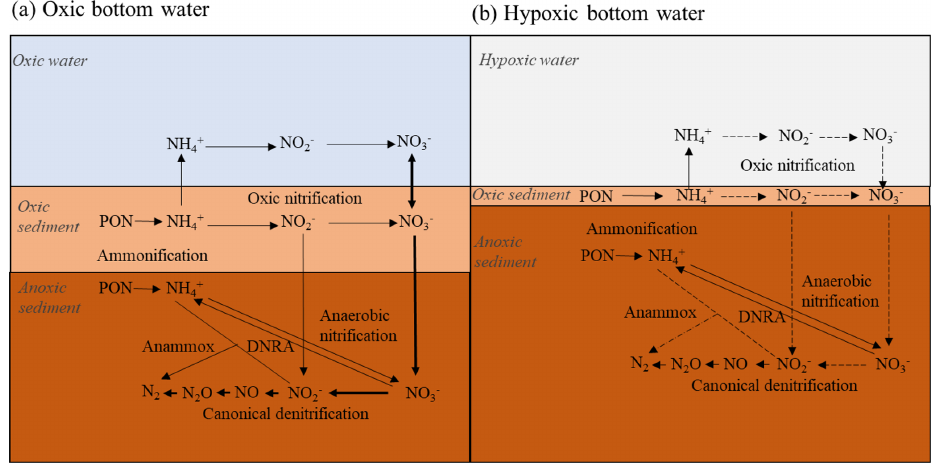
Figure 1. Simplified nitrogen cycling in marine sediments when the bottom water is oxic (a) and hypoxic (b) . Chemical formulae: PON (particulate organic nitrogen), NH + (ammonium), NO − (nitrate), NO − (nitrite), NO (nitrogen oxide), N 2 O (nitrous oxide) and N 2 (nitrogen). 4 3 2 The bold (dotted) arrows indicate reactions advantaged (reduced) by oxygen and nitrate presence (depletion). See text for more details. Modified from Jantti and Hietanen